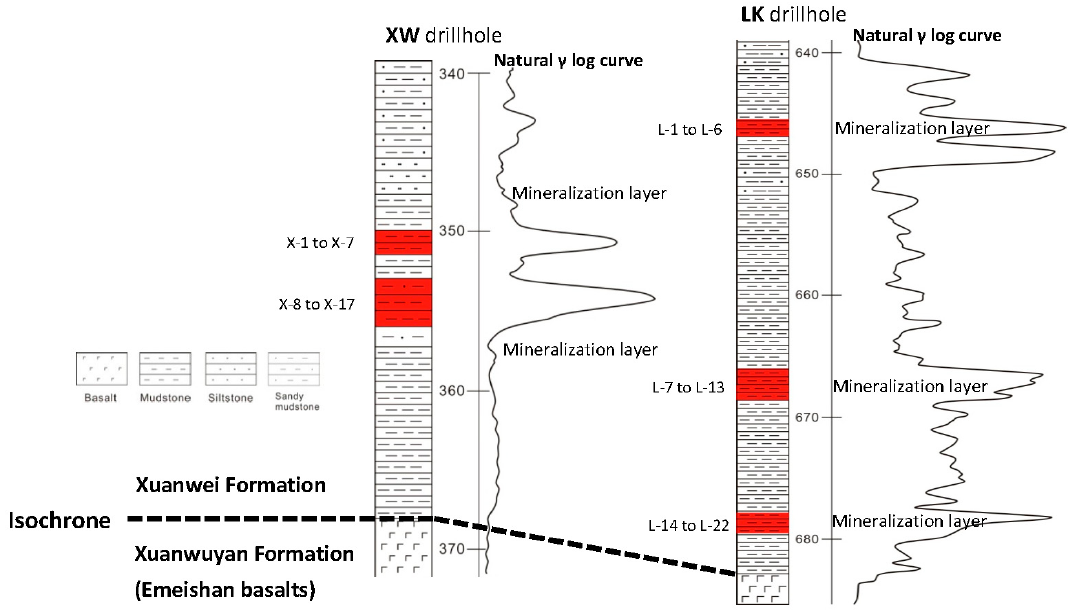
Figure 2. Stratigraphic sections of the XW and LK drill holes. The red areas indicate the sampling locations.